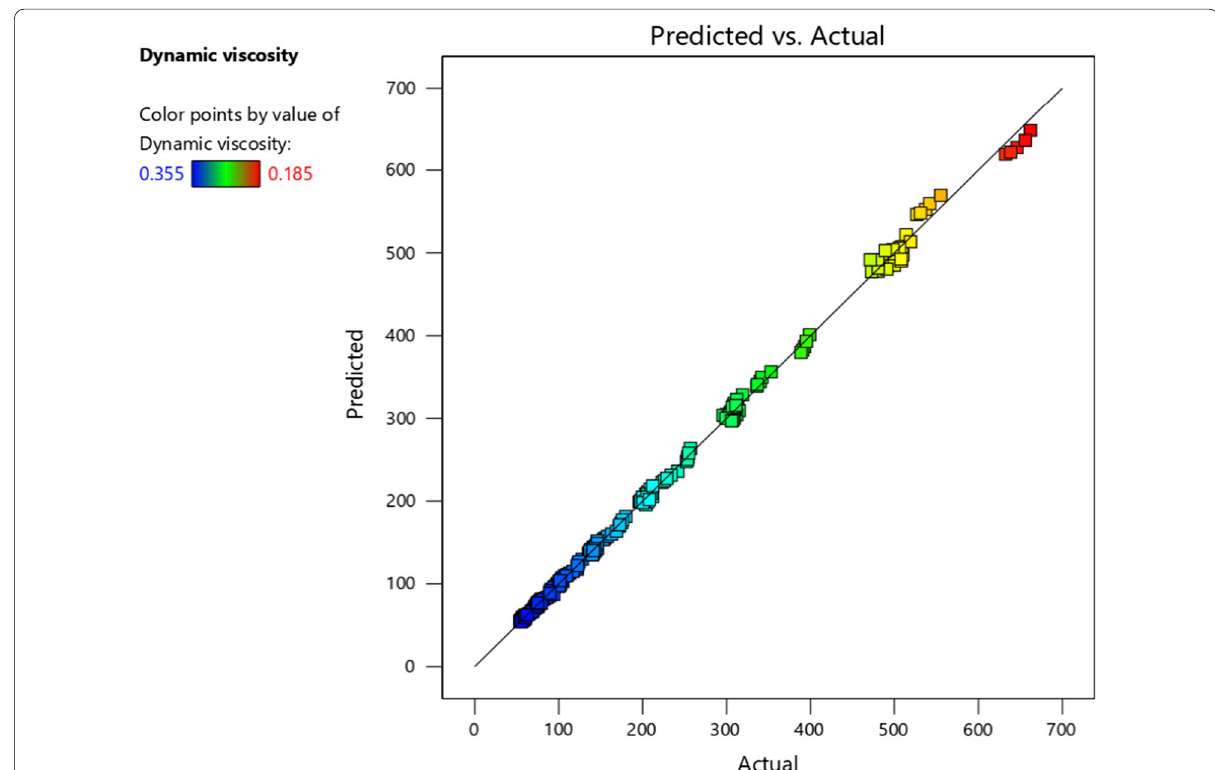
Fig. 15 Comparison between estimated and experimental